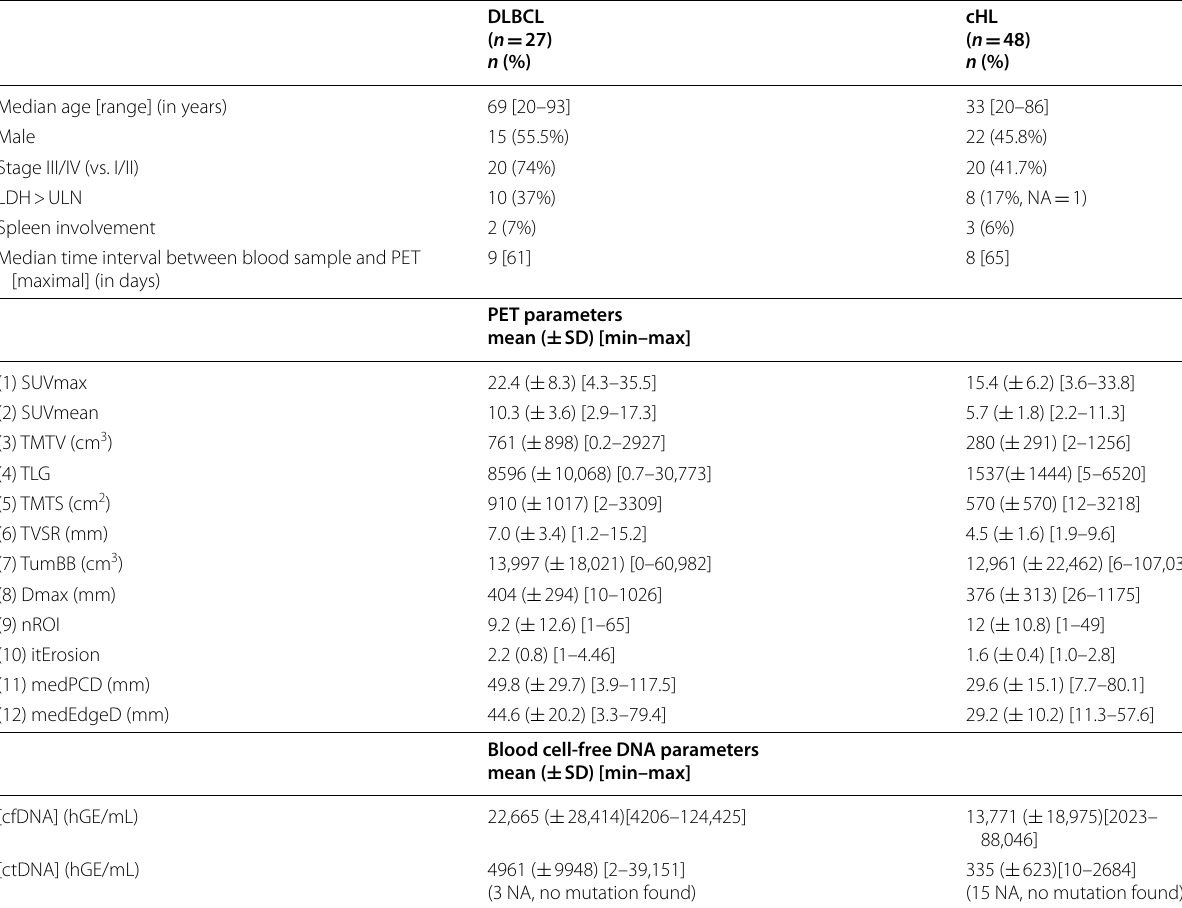
Table 1 Patients characteristics and values of PET and blood DNA parameters